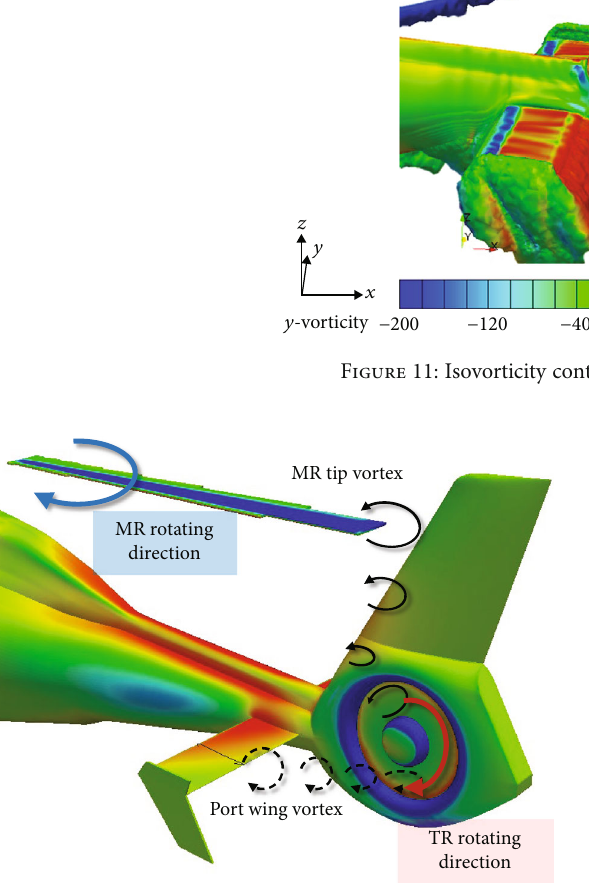
Figure 12: Schematic of vortex and wake directions around the tail